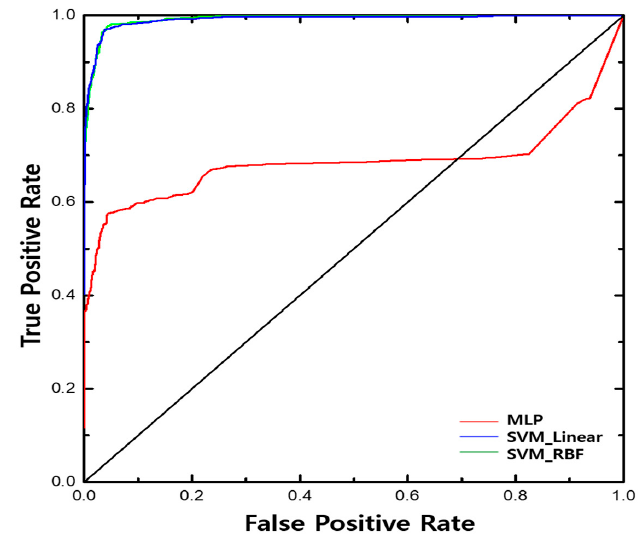
Figure 14. ROC Curve.